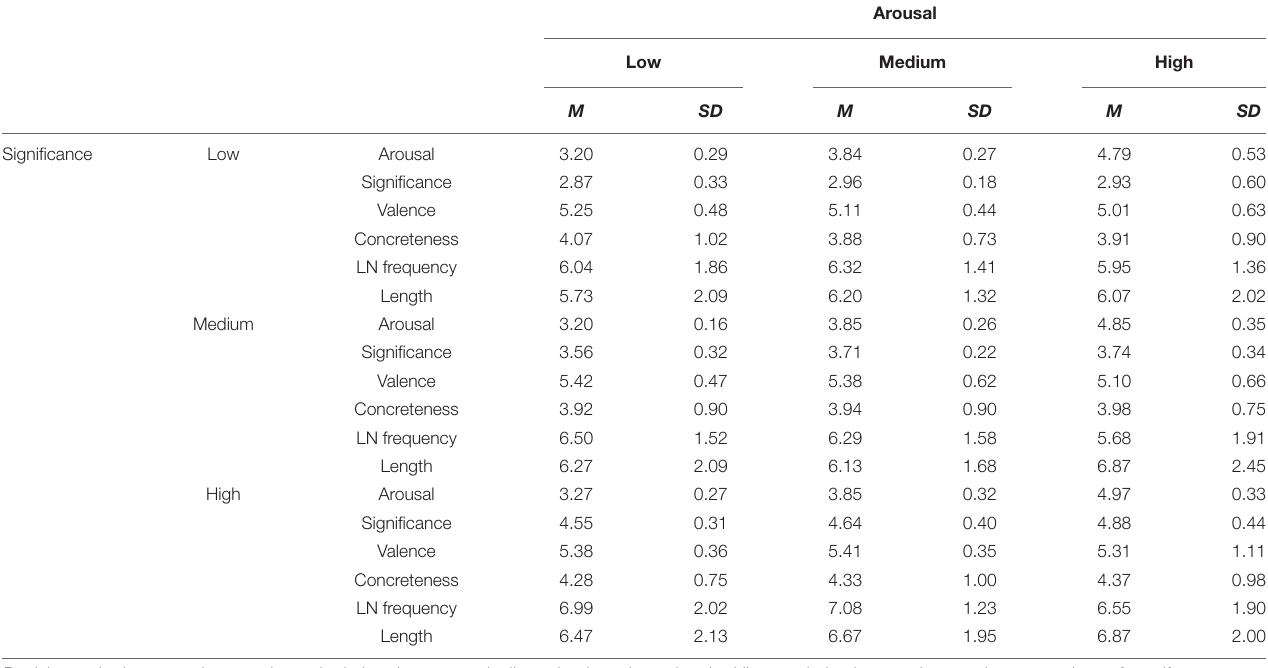
TABLE 2 | Word properties for each group of words calculated on the basis of Affective Norms for Polish Words Reloaded (Imbir, 2015, 2016b).